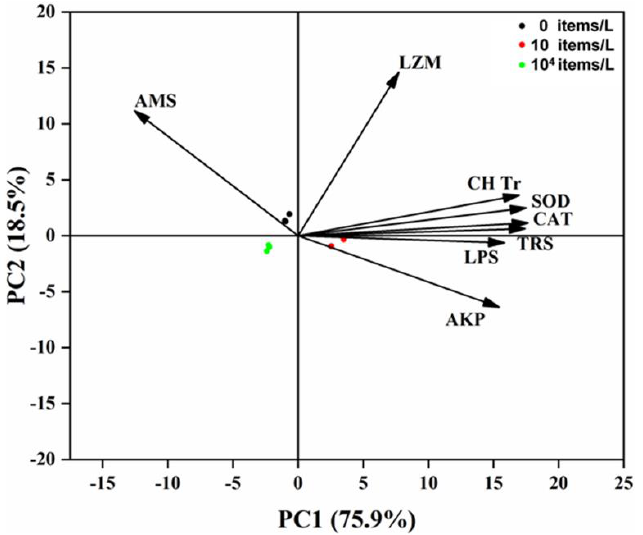
Figure 4. Biplot originating from principal component analysis (PCA) integrating biochemical indi − cators (CH Tr, TRS, LPS, AMS, LZM, AKP, SOD, CAT) and three different